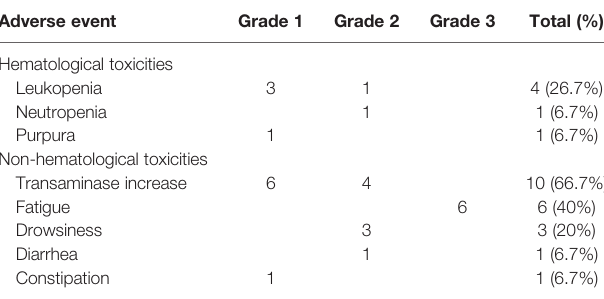
TABLE 3 | Adverse events of Orelabrutinib-containing